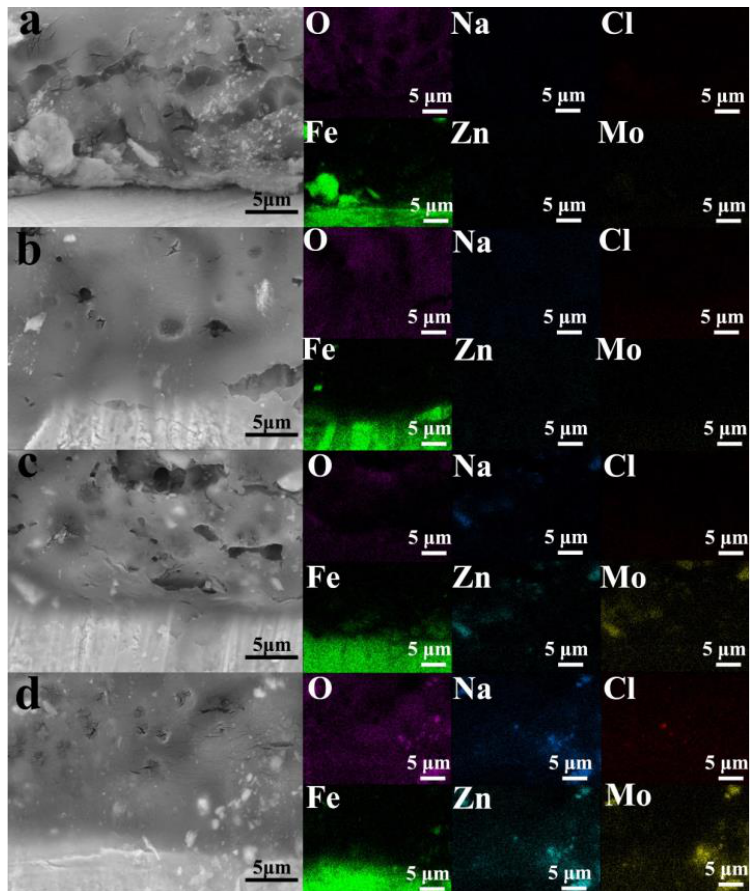
Figure 7. Element distribution of O, Na, Cl, Fe, Zn, and Mo of the cross-section of different coat- ings ( a ) pure resin before immersion, ( b ) pure resin immersed in 3.5 wt% NaCl solution for 1008 h,